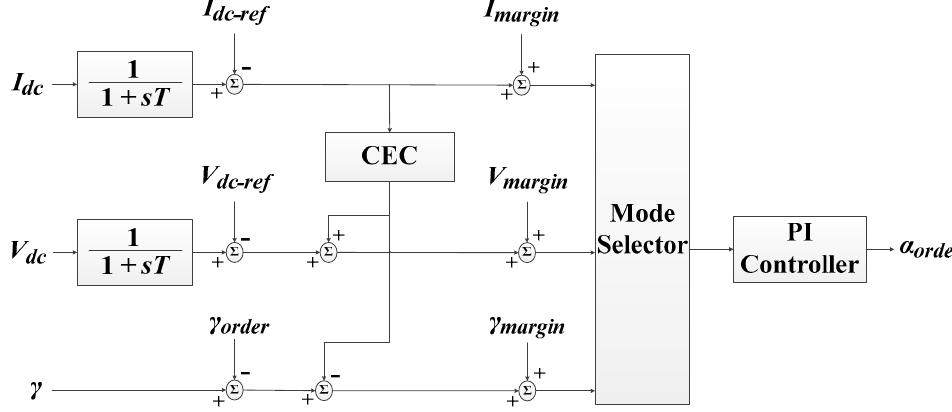
Figure 4. A control diagram of both converters in the CDC7T. Table 3. CDC7T Parameters which can be modified by the system operators (Group B).